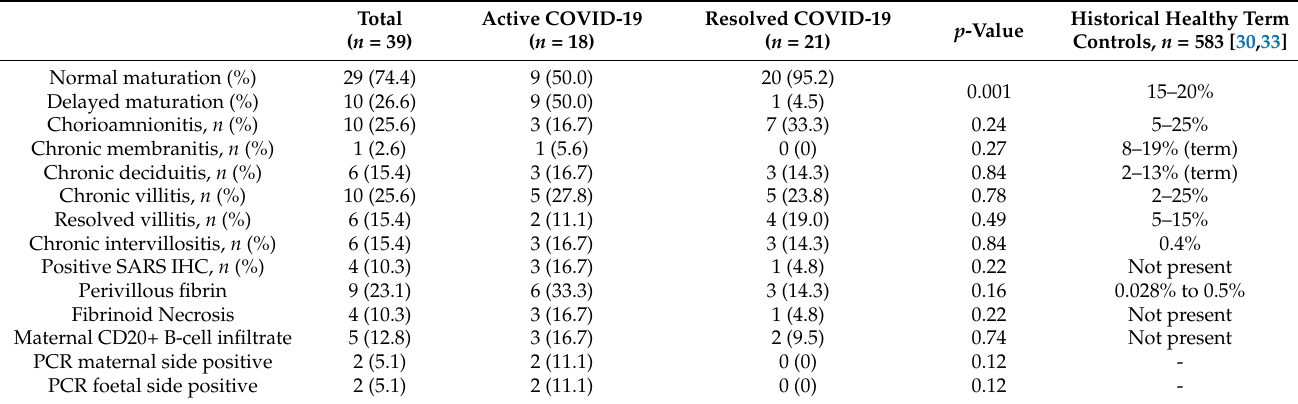
Table 3. Placenta outcomes for the total study population and subgroups active COVID-19 and resolved COVID-19 at the time of giving birth.